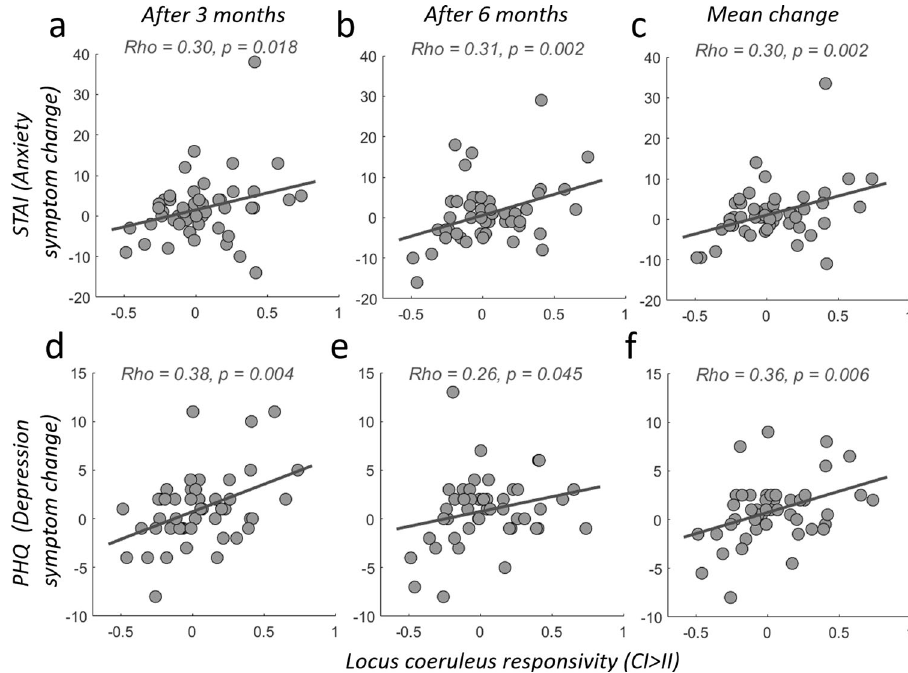
corrected, unsmoothed data with weighted averaging across voxels in the LC-1SD-mask. Please note that the symptom severity used for these